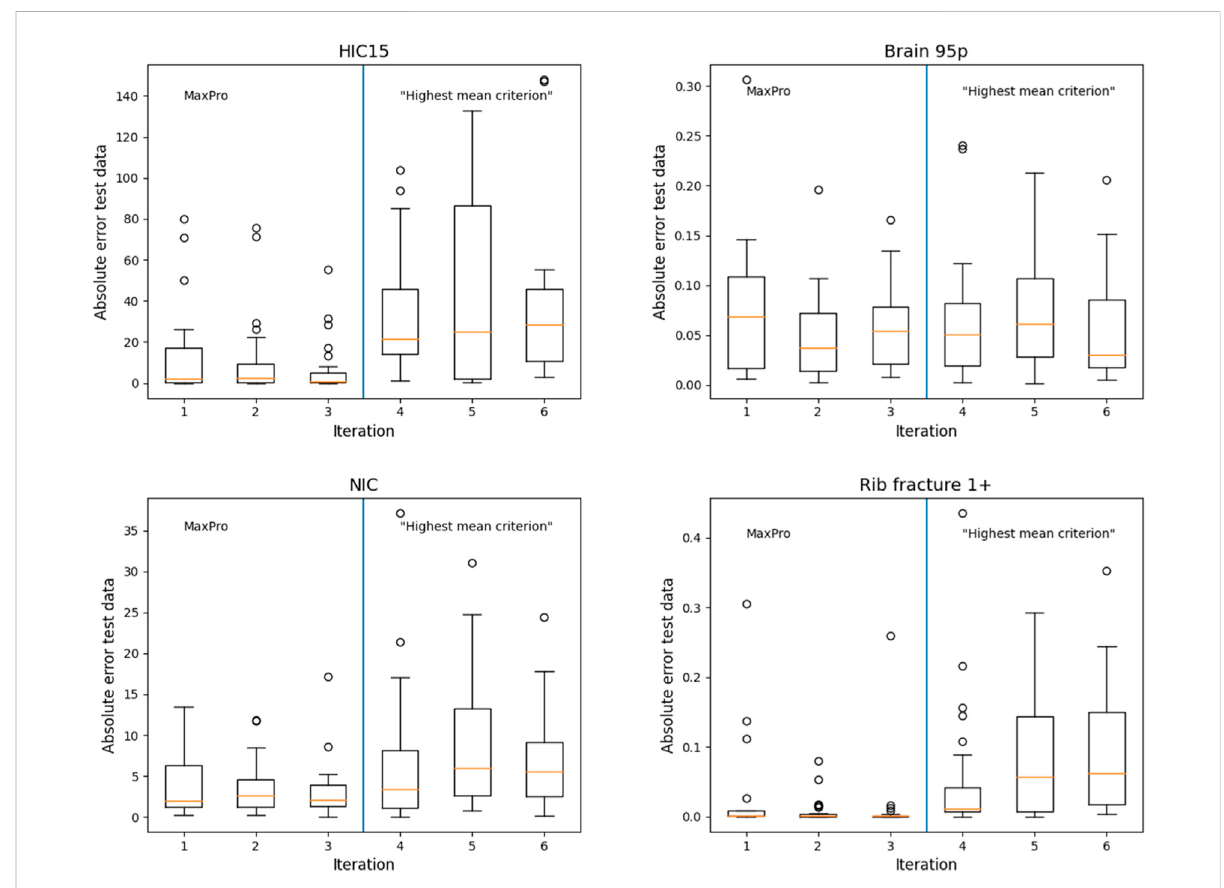
FIGURE 6 Boxplots with absolute error of the predictions on the test data for all iterations.